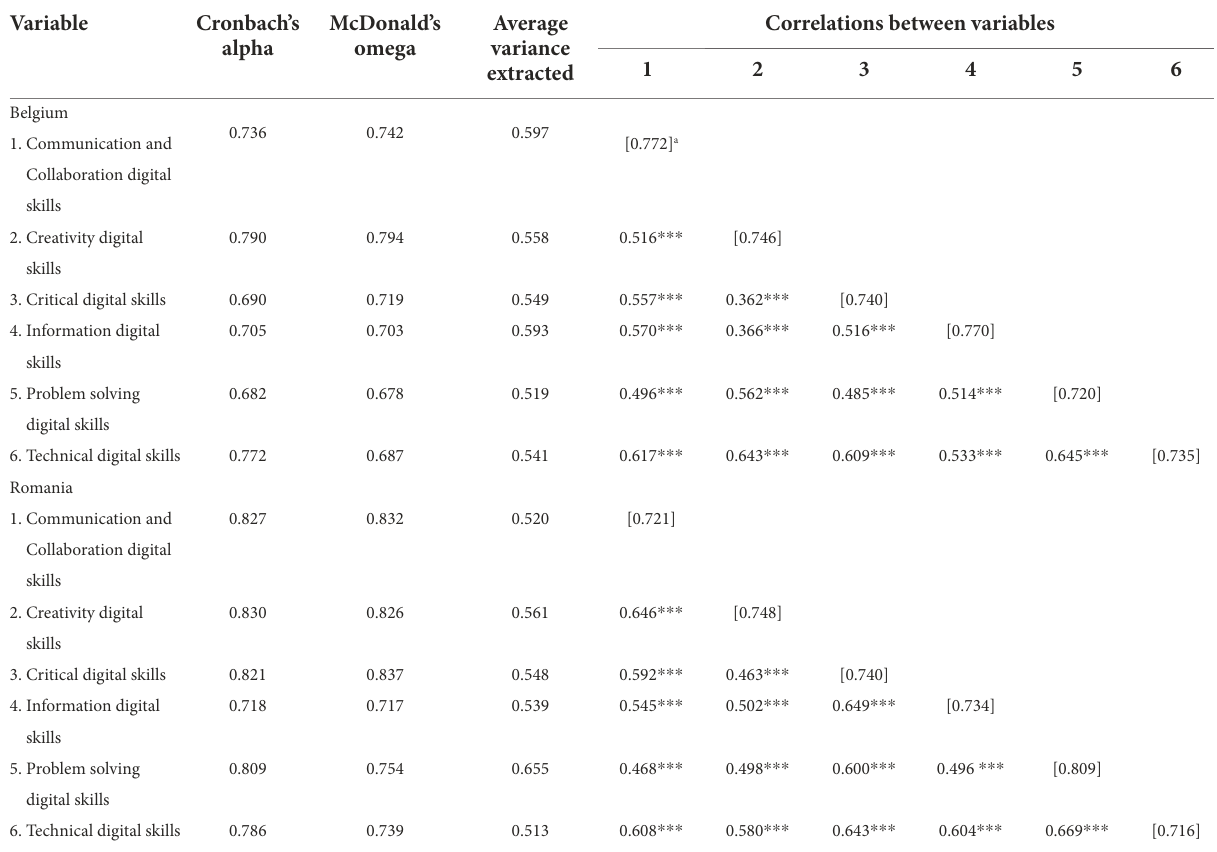
TABLE 2 Results of reliability and validity